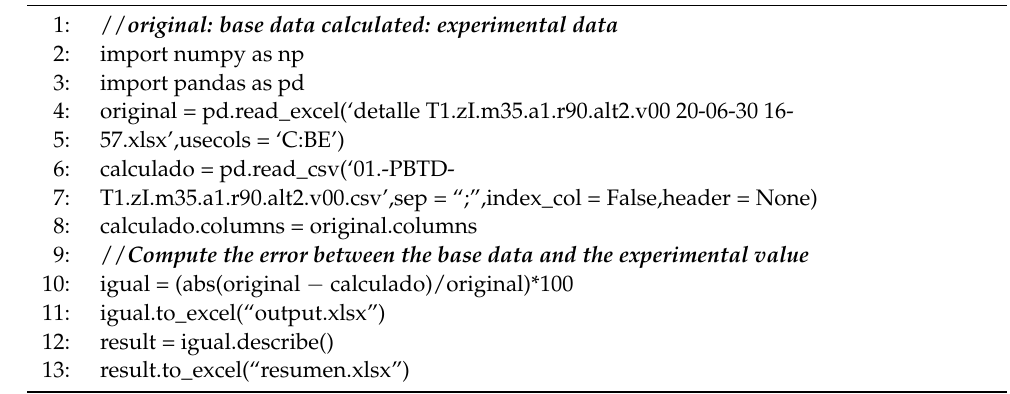
Algorithm 14. Accuracy of the calculations